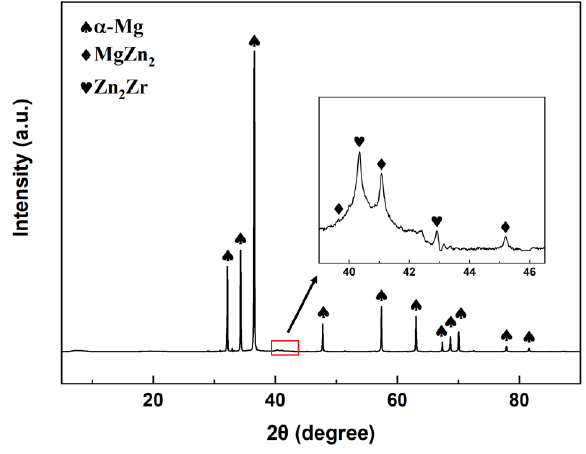
Figure 2. XRD pattern of cast ZK60 Mg alloy.